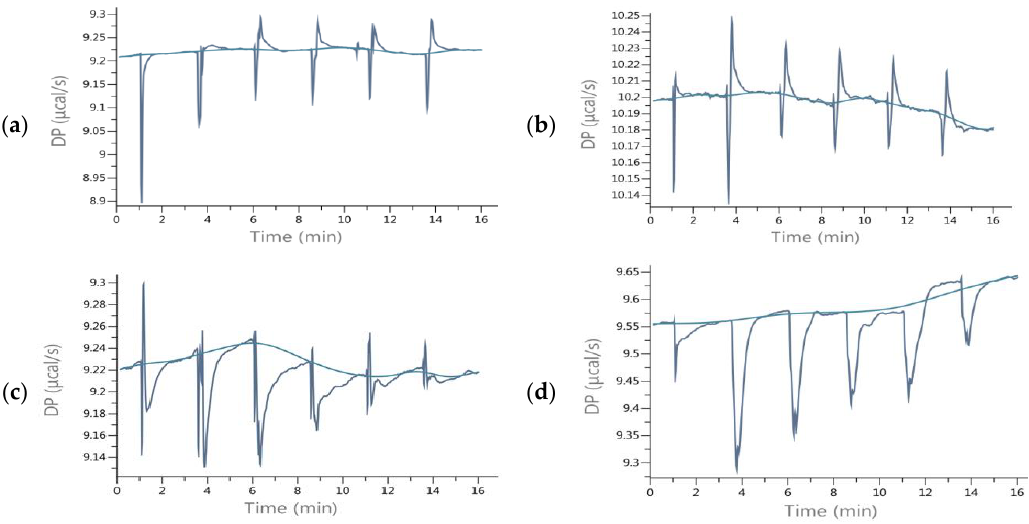
Figure 3. ITC raw data of titration of RANKL with isoflavones ( a ) Daidzein; ( b ) Biochanin A; ( c ) Formononetin+Biochanin A; ( d ) OPG.